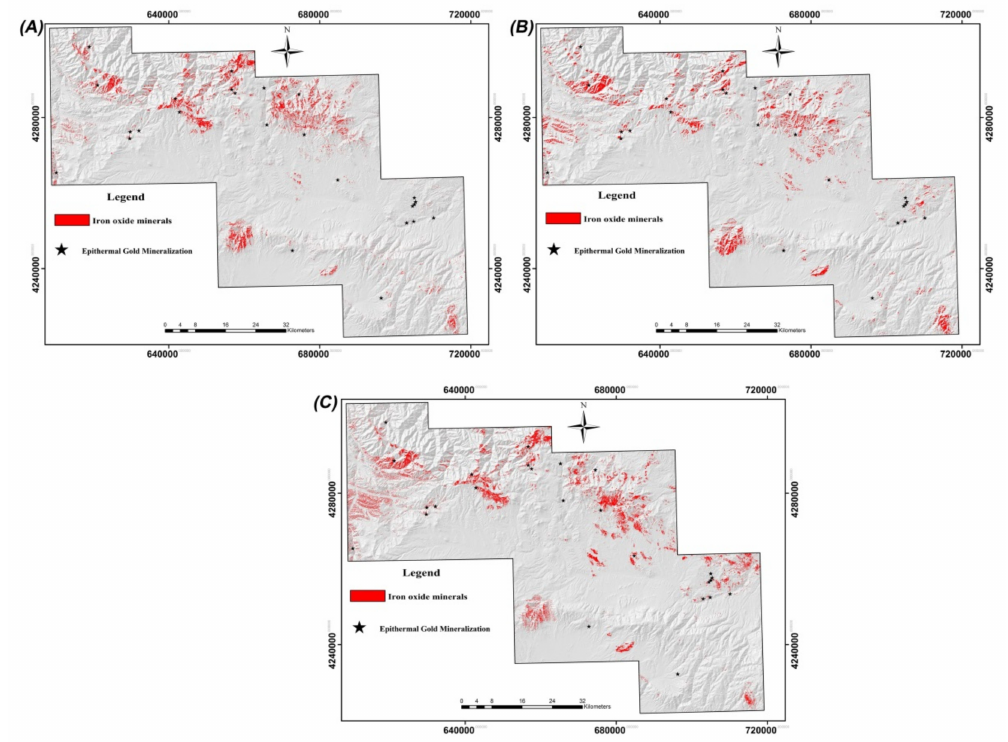
Figure 9. The PCA images derived from Landsat-7 ETM + , Landsat-8 and ASTER selected bands for mapping iron oxide / hydroxide zones (gossan) in the study area overlaid on hill shade. ( A ) The PCA3 image of Landsat-7 ETM + ; ( B ) the PCA2 image of Landsat-8; ( C ) the PCA3 image of